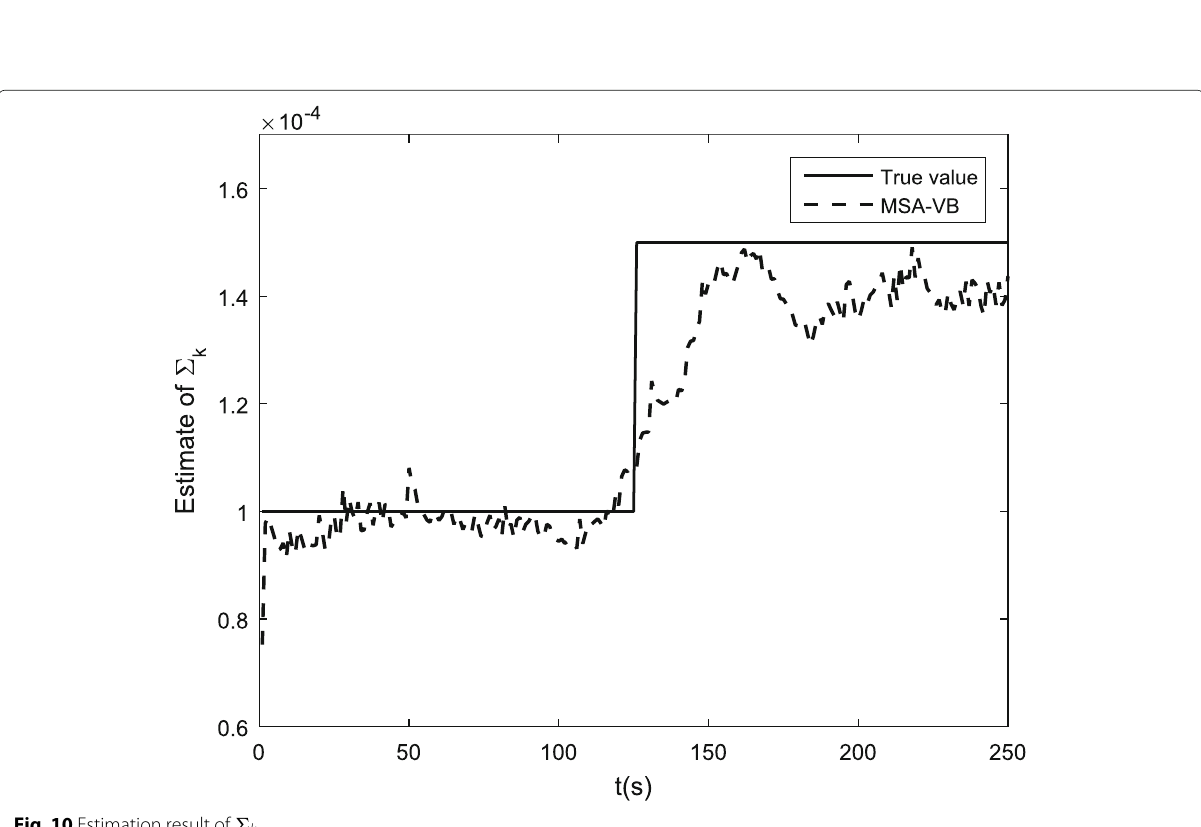
Fig. 10 Estimation result of (cid:2)